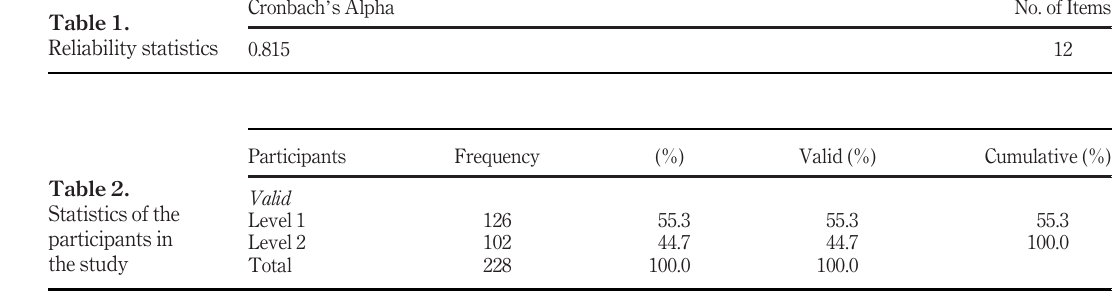
Table 1. Reliability statistics